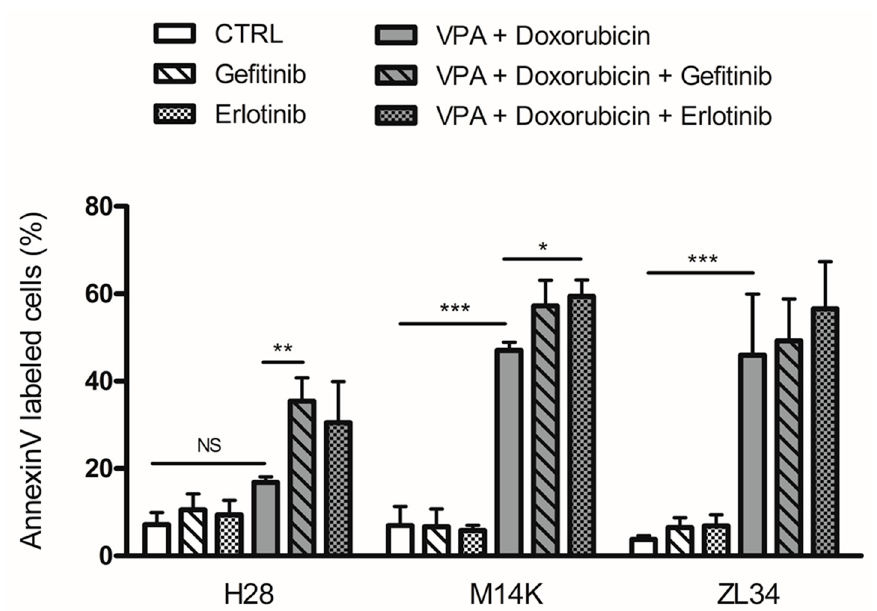
Figure 3. EGFR tyrosine kinase inhibitors increase the apoptosis induced by VPA and doxorubicin. H28, M14K and ZL34 cells were treated with VPA, doxorubicin and / or an EGFR tyrosine kinase inhibitor (gefitinib or erlotinib) and were evaluated for their apoptotic response by an Annexin V assay. Data are expressed as the means ± SD. Comparisons of multiple groups were performed using one-way analysis of variance (ANOVA) followed by Tukey’s multiple comparison procedure. Data are from three independent experiments. * p -value < 0.05; ** p -value < 0.01; *** p -value < 0.001; NS: not significant.